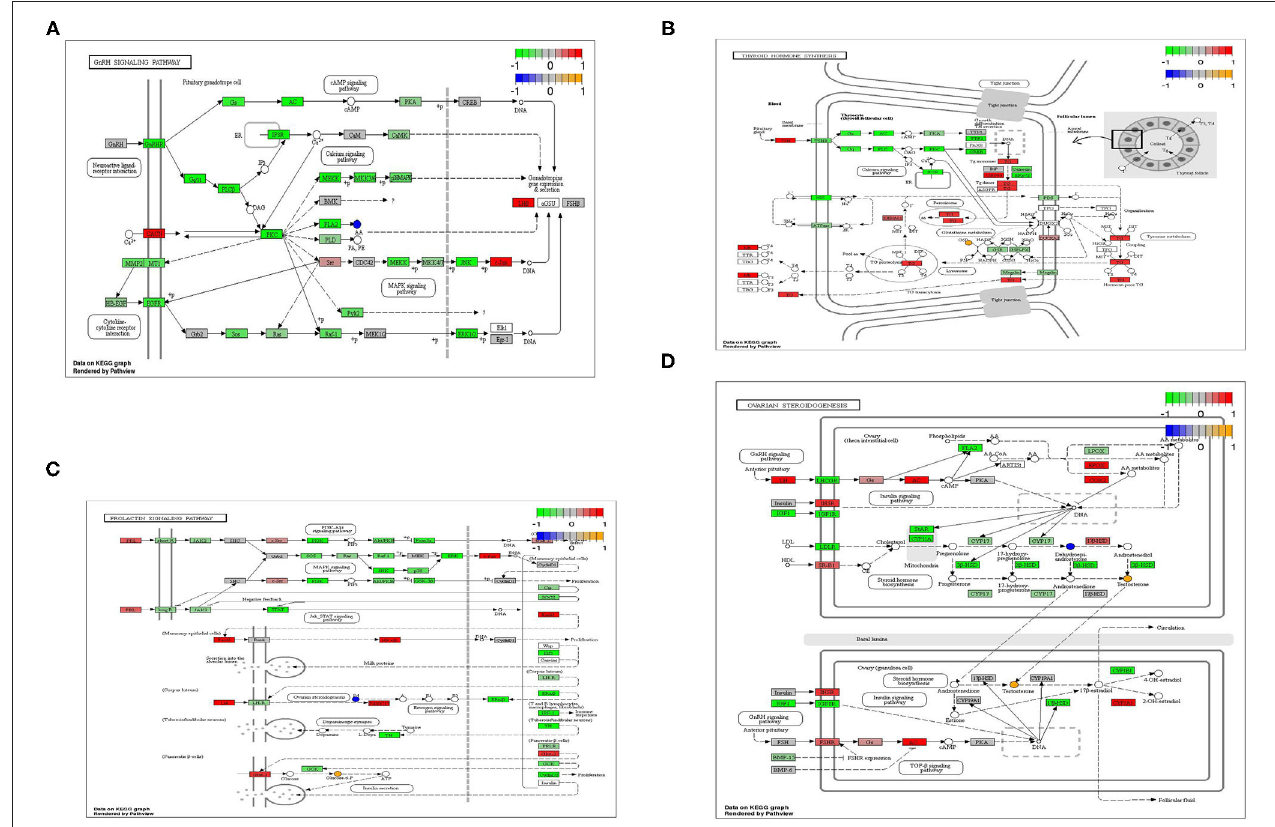
FIGURE 4 | (A) GnRH signaling pathway of differential metabolites and differential transcripts. (B) PRL signaling pathway of differential metabolites and differential transcripts. (C) Thyroid hormone synthesis pathway of differential metabolites and differential transcripts. (D) Ovarian steroidogenesis pathway of differential metabolites and differential